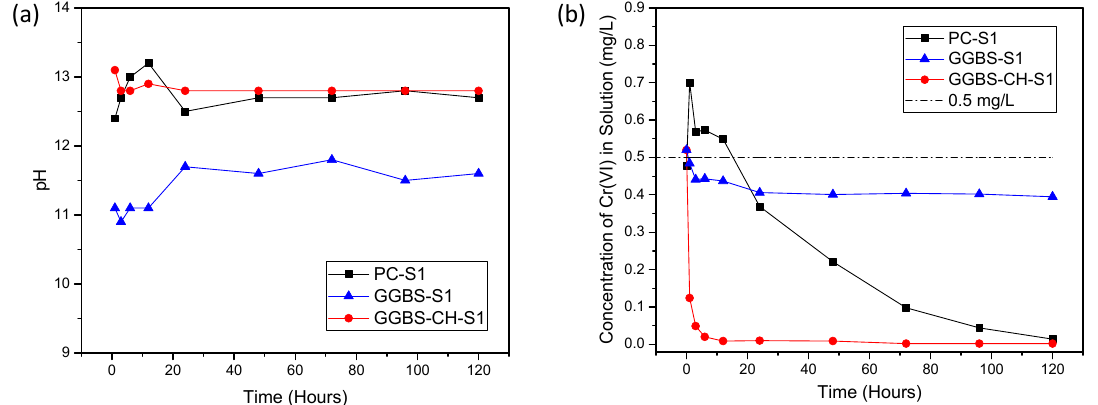
Figure 1. Time profiles of ( a ) the pH values of S1 samples’ suspensions and ( b ) the Cr(VI) concentrations in the S1 samples’ filtered solutions measured from 0 to 120 h.